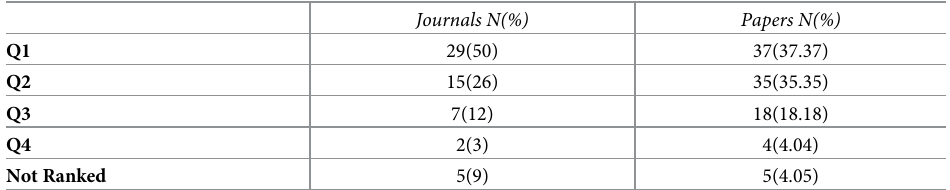
Table 3. Quality of included journals and papers based on